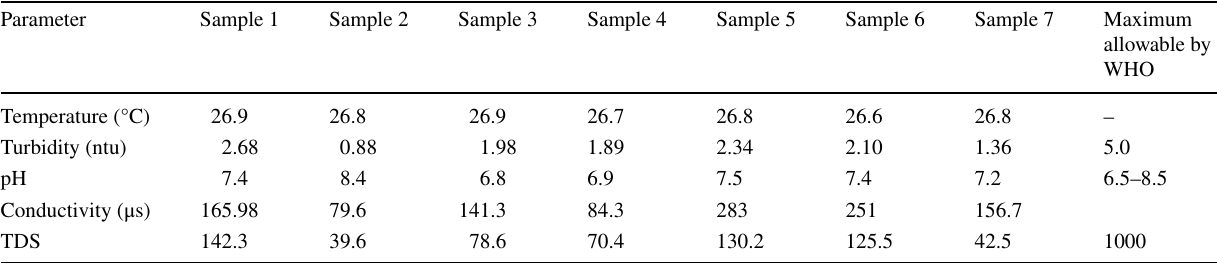
Table 1 Physico-chemical parameters of Kakamega bore-hole water samples